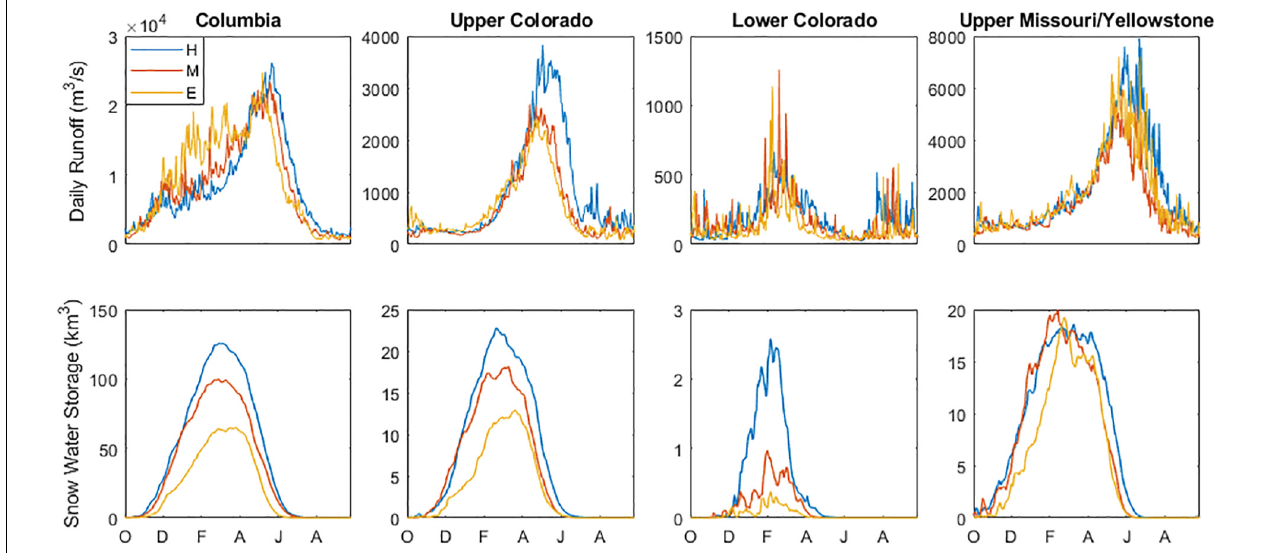
FIGURE 6 | Average daily runoff (top row) , and snow accumulation (bottom row) over each western watershed for the historic (blue), mid-century (orange), and end-century (yellow) periods.